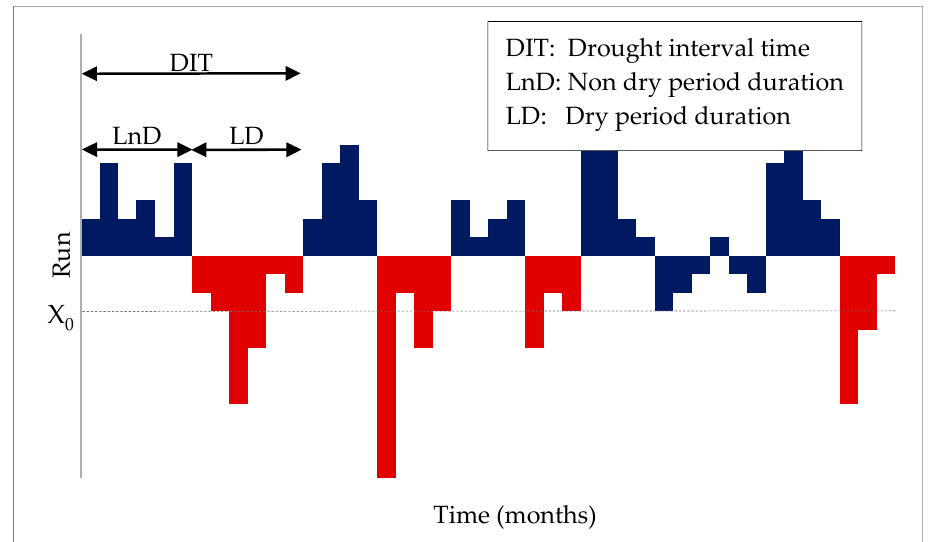
Figure 1. Illustration of drought characteristics using the run theory for a given threshold level of X 0 where the drought events are presented with the red bars over time.